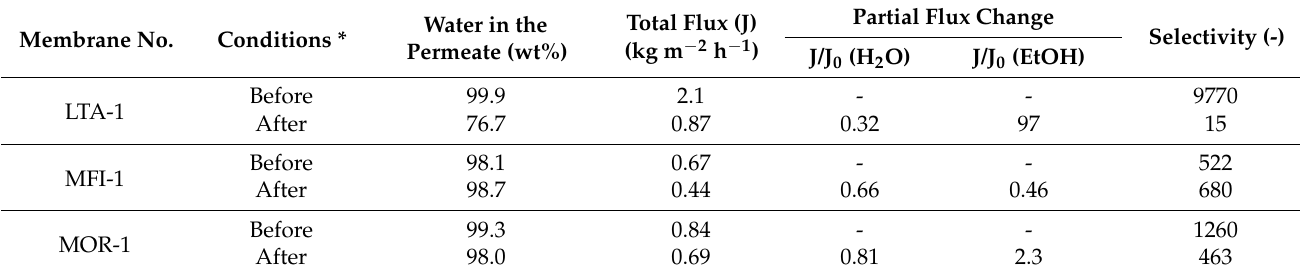
Table 2. Dehydration performance measured by pervaporation tests with a 90 wt% ethanol solution as feed at 75 ◦ C. Membrane No.